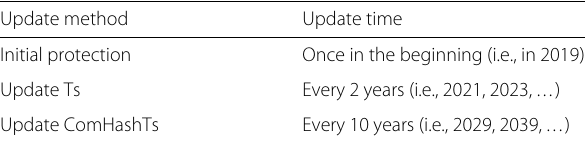
Table 1 Schedule for updating the integrity proof